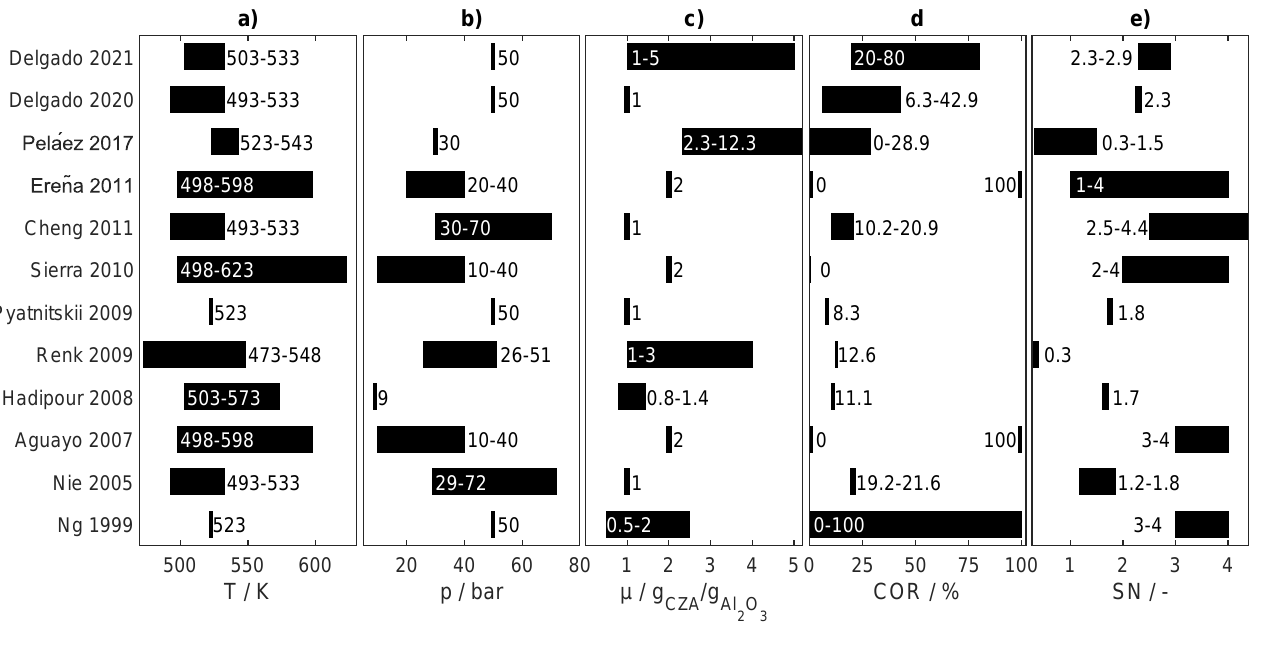
Figure 1. Overview of lumped models’ validity ranges regarding ( a ) temperature ( b ) pressure ( c ) CZA-to- γ -Al O weight ratio µ ( d ) carbon oxide ratio COR and ( e ) stoichiometric number SN. 2 3 Models [15–26] named after first author and year of